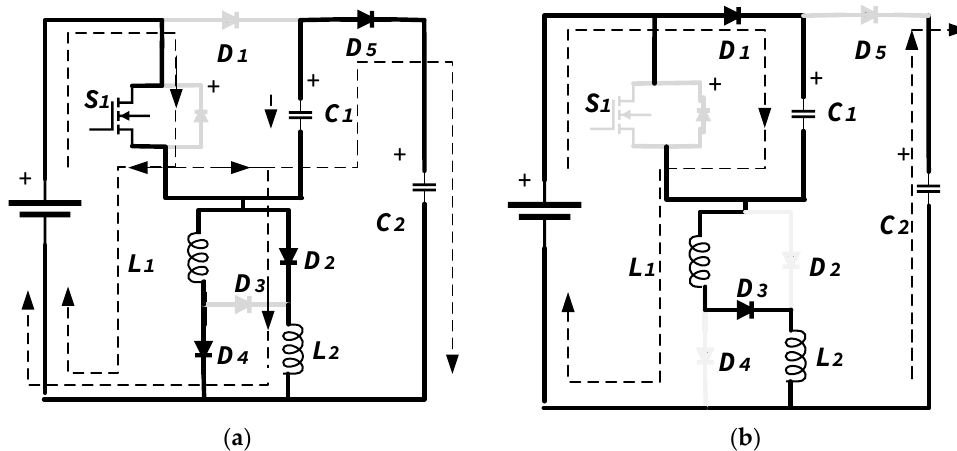
Figure 3. The proposed DC – DC boost converter for the time durations that the switch is in ( a ) on and ( b ) off-states.